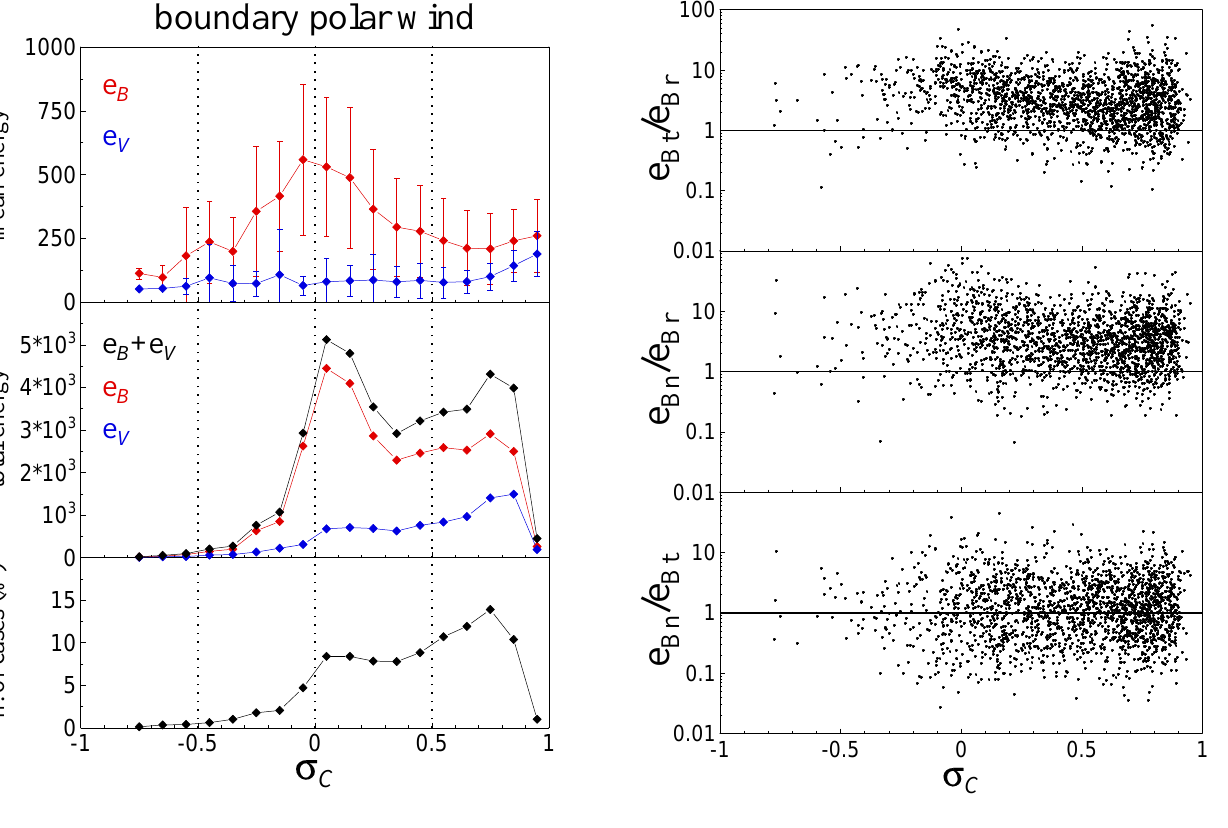
Fig. 4. The same as in Fig. 3, for boundary polar wind. Fig. 5. Geometrical properties of the magnetic fluctuations versus cross-helicity for the core polar wind sample. Plotted data are the ratios between values of e B along the rtn frame axes (see definition in the text).